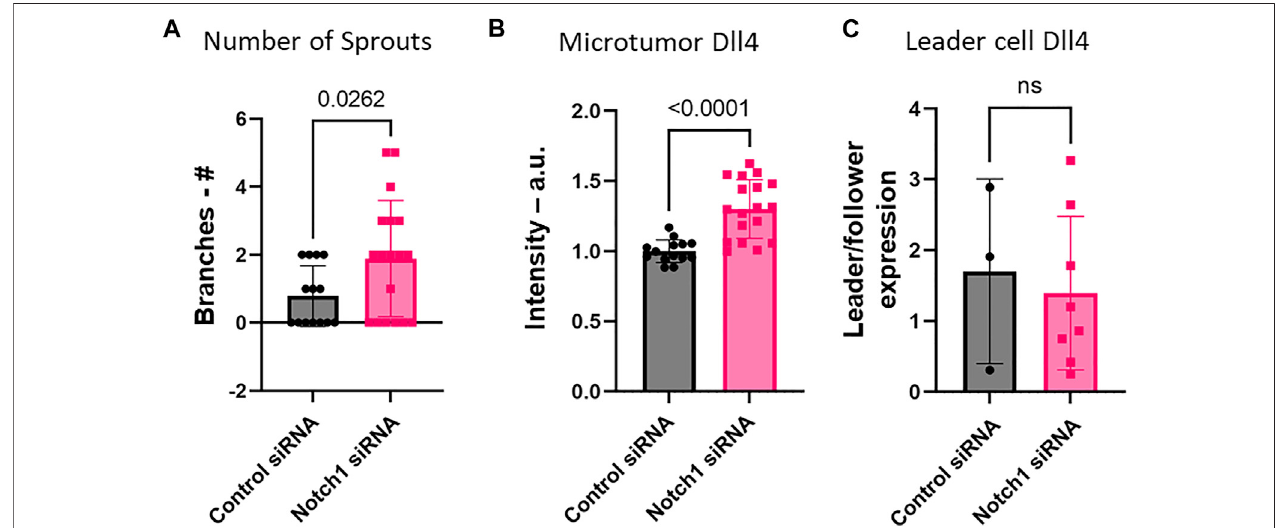
FIGURE10| TheeffectofNotch1siRNAonTGF β -inducedcancerinvasion. (A) Notch1siRNA increasedthenumberofsprouts.Themicrotumorswereformed by HeLa cells. (B) Expression of Dll4 mRNA in microtumors was enhanced by Notch1 siRNA compared to control siRNA. (C) Once an invading sprout is formed, the expressionofDll4mRNAinleadercellsrelativetofollowercellswasnotsigni fi cantlyaffectedbyNotch1siRNA.Student ’ st-testwasusedtocomparetheDll4expression and the number of branches across groups (ns p > 0.05). For (A , B) control siRNA n = 14 spheroids, Dll4 siRNA n = 18 spheroids. For (C) control siRNA n = 3 branches and Dll4 siRNA n = 8 branches. Results are from two experiments performed across different